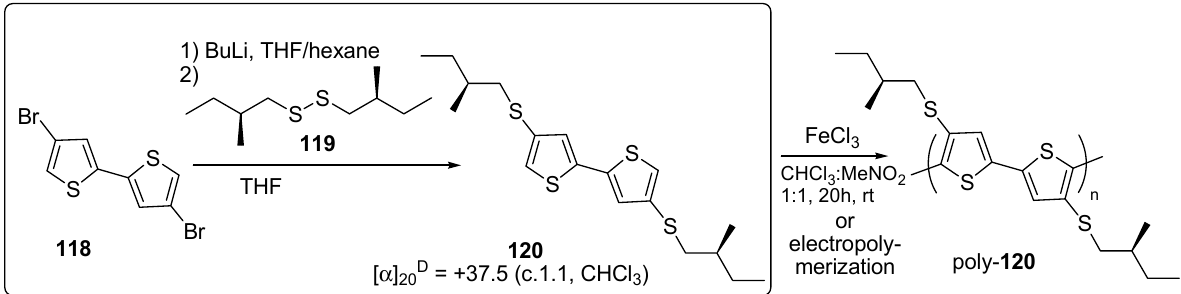
or or electropoly- electropoly- poly- 120 merization merization